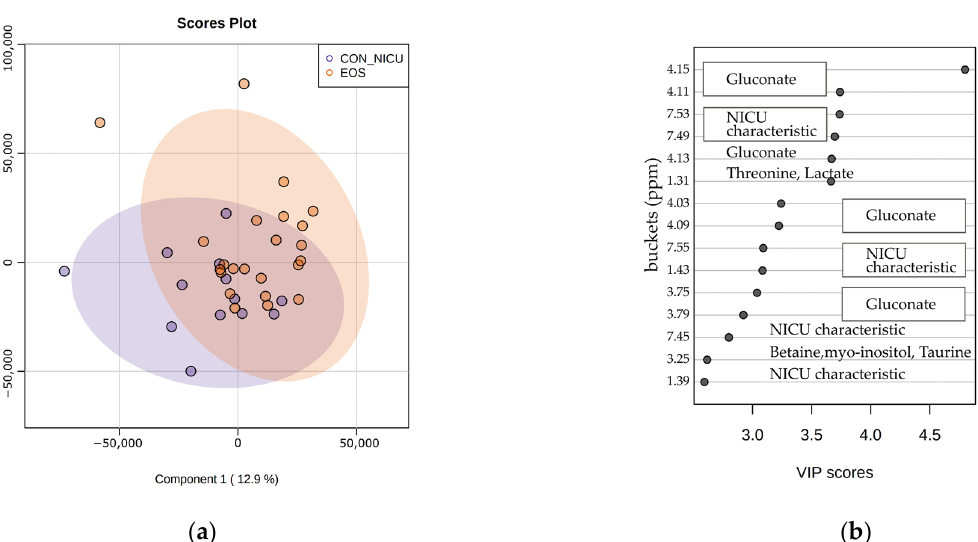
Figure 3. Multivariate analysis of NMR data belonging to neonates diagnosed with EOS (orange circles) and neonates hospitalized in NICU without EOS (purple circles). ( a ) PLS-DA scores plot of the EOS and control group. ( b) VIP scores and metabolites related to buckets with different concen- tration among the two groups.